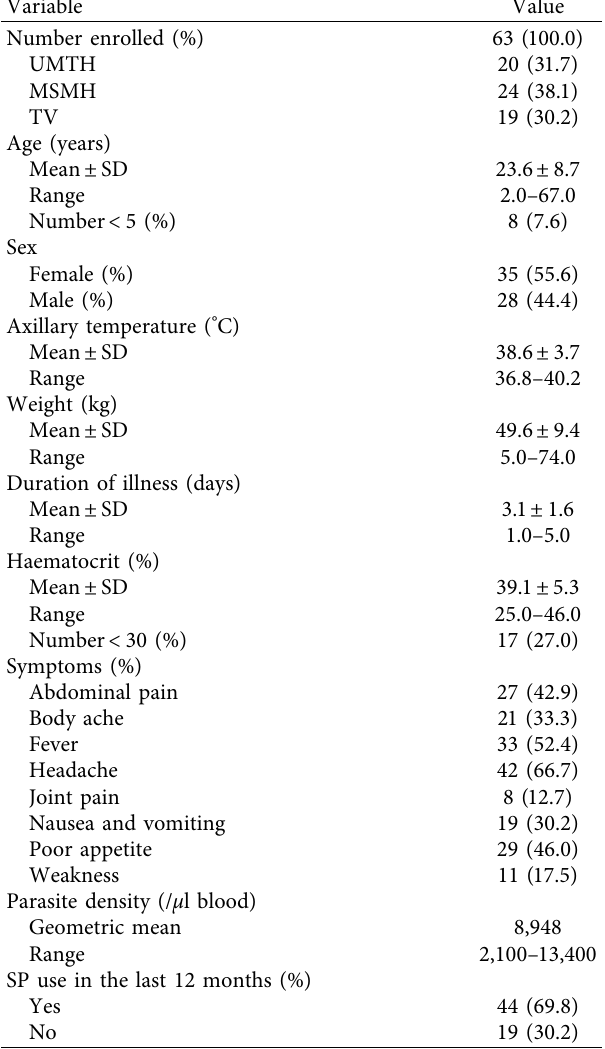
Table 1: Baseline characteristics of the subjects whose samples were